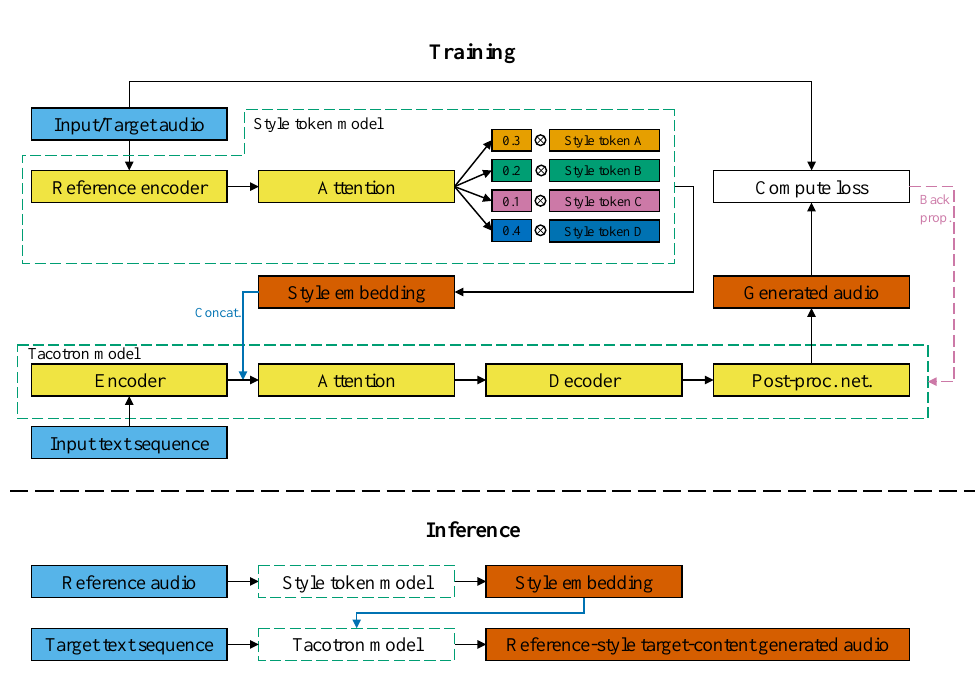
Figure 1. Overall architecture of Tacotron with global style